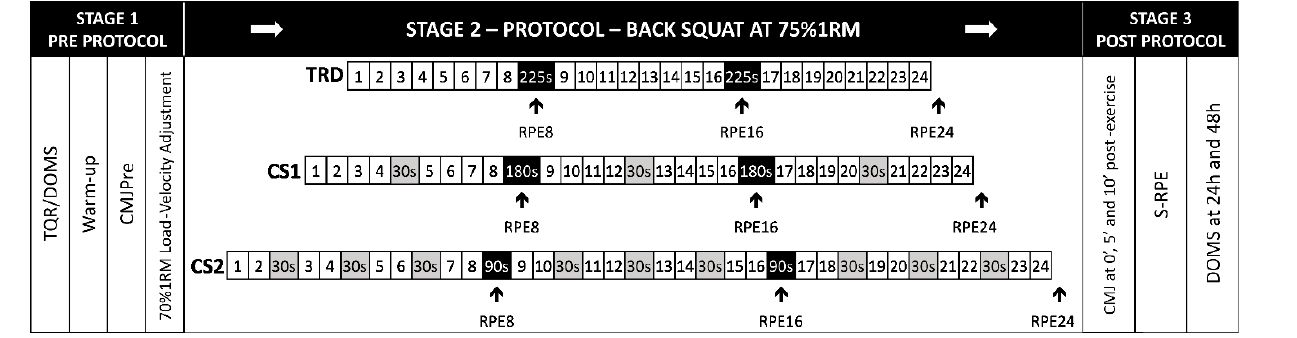
Figure 2. Study design—Traditional (TRD), Cluster 1 (CS1), and Cluster 2 (CS2). TQR: Total Quality Recovery Scale; DOMS: Delayed Onset Muscle Soreness (pre-protocol, 24 and 48 h post protocol); CMJ: jump height before (CMJPre) and after (CMJ at 0 ′ , 5 ′ , and 10 ′ ) protocol. RPE8, 16, 24: Rating of Perceived Exertion at the end of each set; S-RPE: Rating of Perceived Exertion for overall session.